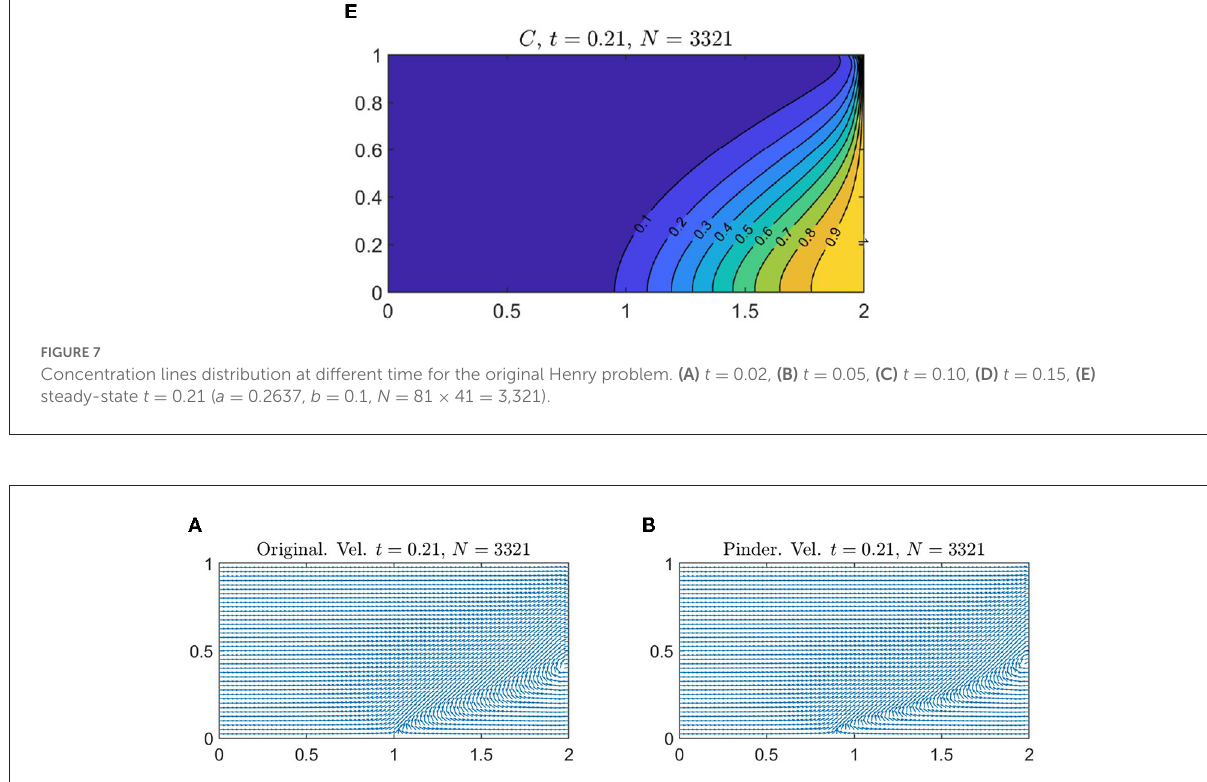
FIGURE8 (A) Henry problem steady-state velocity vector field with normalized arrows ( a = 0.2637, b = 0.1, N = 81 × 41 = 3,321). (B) Pinder version steady-state velocity vector field with normalized arrows ( a = 0.2637, b = 0.035, N = 81 × 41 =